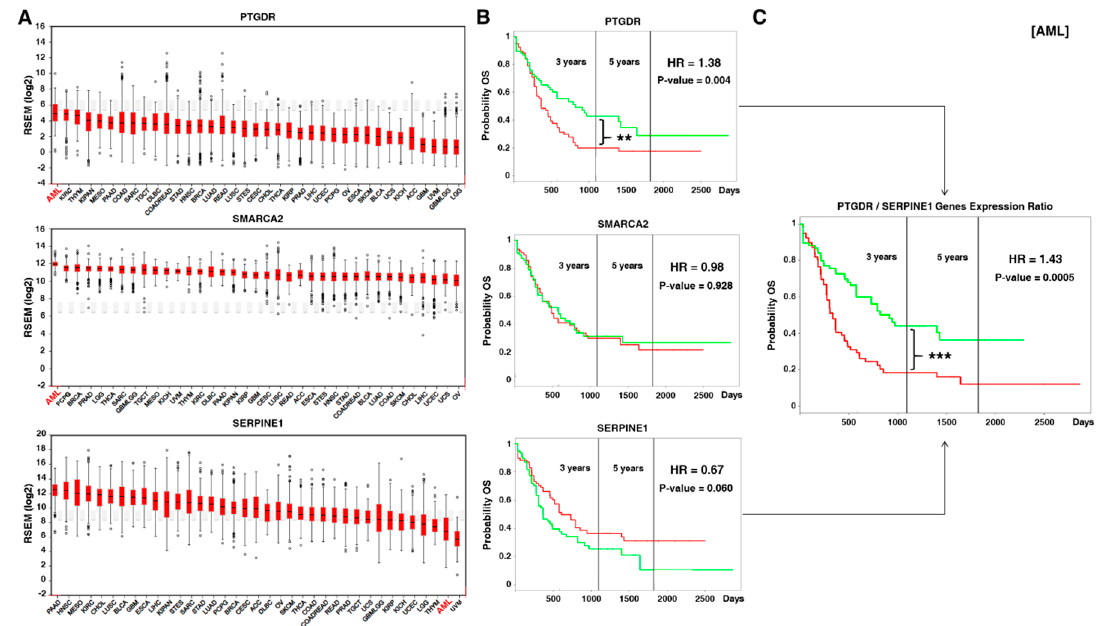
Figure 5. E2F–TFDP route has prognostic relevance in AML patients. ( A ) Within OOS-deregulated genes, two of them (PTGDR and SMARCA2) had the highest expression in AML compared to other tumor types, while SERPINE1 had the second lowest expression (data from TCGA patients). ( B ) Prognostic relevance of the expression of PTGDR, SMARCA2, and SERPINE1 individually in AML patients. PTGDR expression is significantly related with worse relapse-free survival in AML patients. The green line corresponds to patients with low amounts of the corresponding protein, while the red line indicates higher levels. ( C ) The PTGDR / SERPINE1 expression ratio significantly correlates with worse relapse-free survival in AML patients. The combination of high expression of PTGDR and low expression of SERPINE1 is depicted in red, while the combination of low PTGDR expression and high SERPINE1 expression is shown in green. ** and *** indicate statistically significant differences.